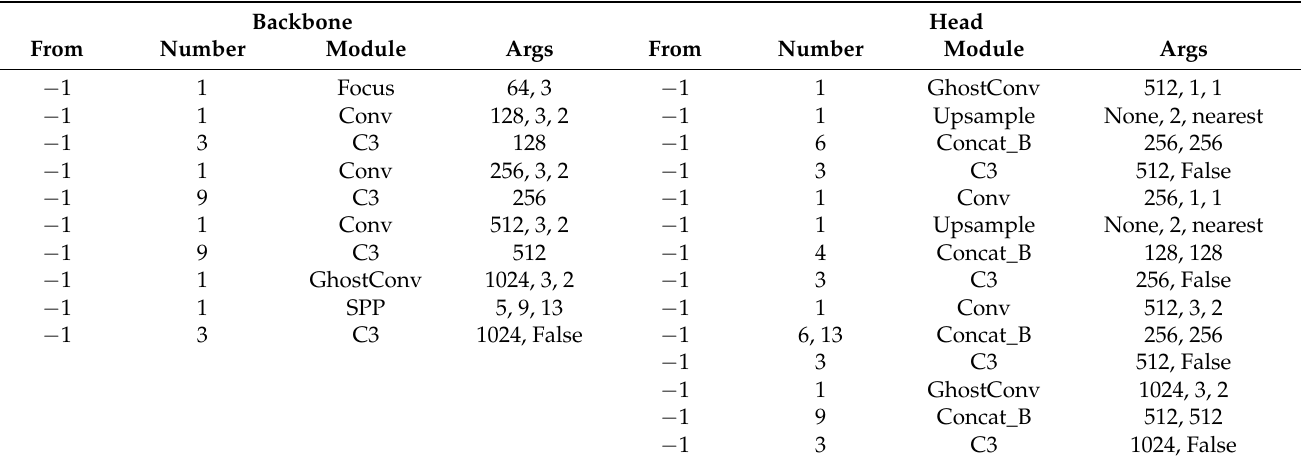
Table 1. Configuration table of Model E transmission line disaster prevention and safety detection model (from = − 1 represents the current module connected to the previous module, the number represents the number of the current module, the module represents the type of the current module, and Argus represents the parameters of the current